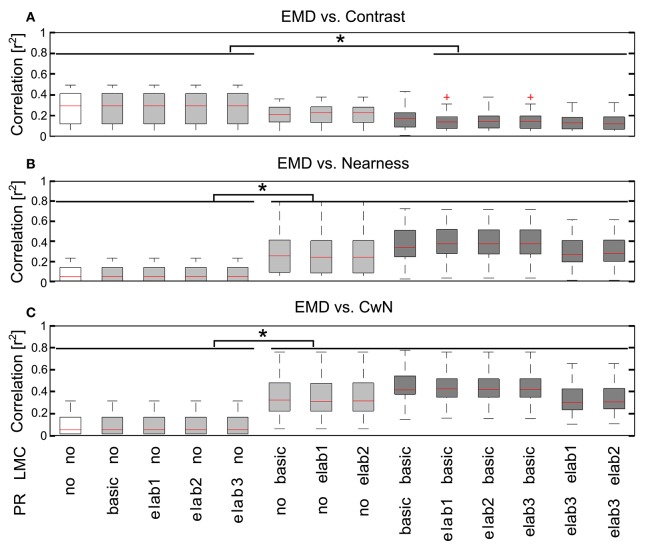
Consequences of the different peripheral processing units on information representation at the EMD output. Correlations between the motion energy profile of EMDs and the local contrast map (A), the nearness map (B), and the CwN map (C) for all 37 natural environments tested illustrated by box plots (red line, median; box, 25–75 percentile; red cross, outlier). Correlations were determined for 14 model variants, as indicated below the figure panels [PR: PR model variants (see Figure 2), in which no means without any processing at the PR stage; LMC: LMC model variants (see Figure 2), no means without LMC stage signal processing. White: EMD without any peripheral processing; gray: EMDs with different PR models, but without LMC processing (four gray boxes on the left), and EMDs with different LMC models, but without PR processing (three gray boxes on the right); black: EMDs with different combinations PR and LMC models]. Asterisks indicate a significant difference (p < 0.05, Kruskal–Wallis test with post hoc multiple comparison).